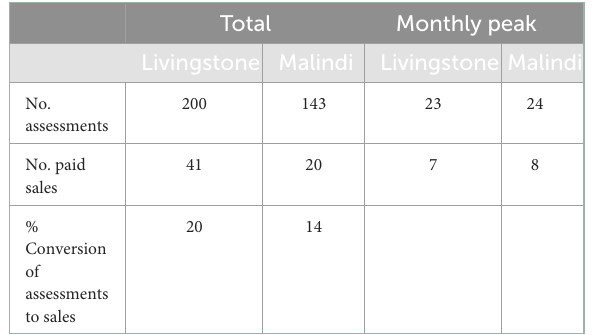
TABLE 4 Reported average tariffs and tariffs fixed under the Minimum Viable Product (MVP)—per pit or tank.